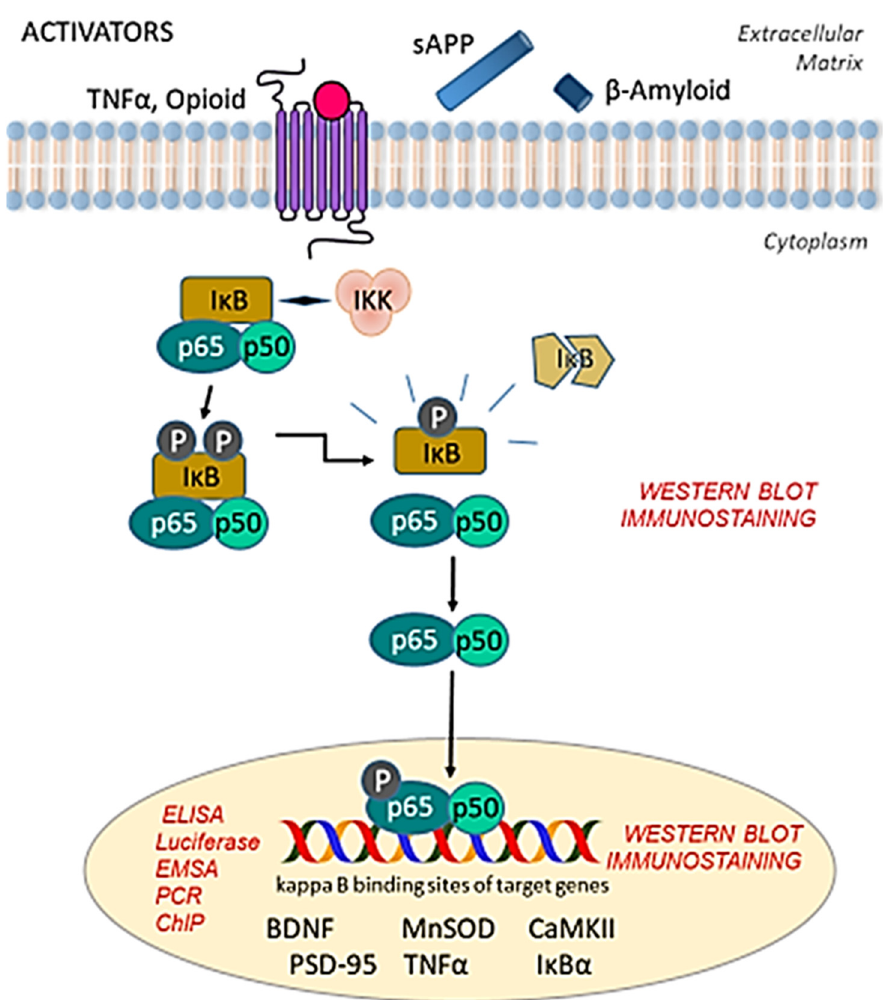
Figure 1. NF- κ B signaling pathway. The transcription factor NF- κ B is constitutively expressed in the central nervous system (CNS), where it can be activated by several stimuli, including TNF α , opioids, β -amyloid, and sAPP, to name a few. The NF- κ B complex is sequestered in a dimer form (with p65/p50 dimers as the most common composition) in the cytoplasm, where it is bound by I κ B. Upon activation by various stimuli, IKK interacts with the inhibitory I κ B, resulting in phosphorylation, ubiquitination, and degradation of I κ B, rendering the dimer free to translocate to the nucleus. Here, the dimer binds to kappa B binding sites of several gene targets that may be involved in cell survival in neurons or inflammatory pathways in glia. Dimers consisting of p65/p50 tend to be transcriptionally active, whereas p50 homodimers tend to suppress gene transcription. Red text indicates methods appropriate to investigate specific components of NF- κ B signaling. BDNF = brain-derived neurotrophic factor; CaMKII = calcium-calmodulin kinase II; ChIP = chromatin immuno- precipitation; ELISA = enzyme-linked immunosorbent assay; EMSA = gel electrophoresis mobility shift assay; I κ B = inhibitory κ B protein; IKK = inhibitory κ B protein kinase; MnSOD = manganese superoxide dismutase; PCR = polymerase chain reaction; PSD-95 = postsynaptic density protein-95; sAPP = secreted amyloid precursor protein; TNF α = tumor necrosis factor alpha.